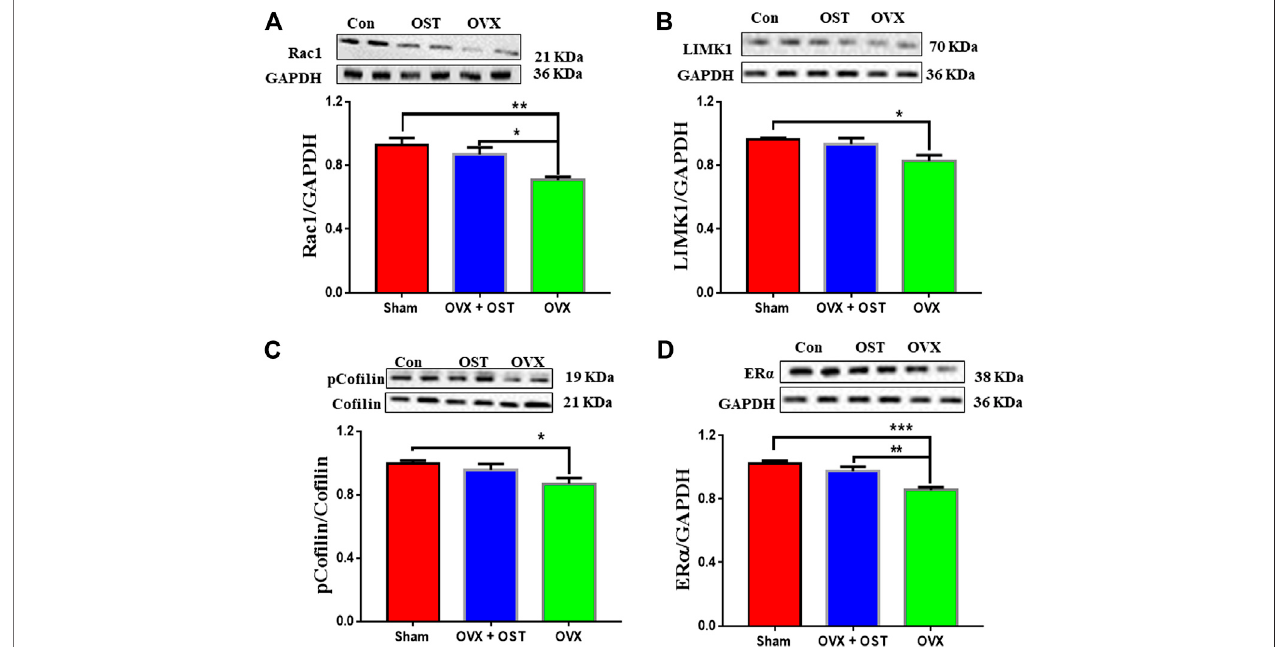
FIGURE 6 | Effects of OST on OVX-mediated alterations in the protein levels of Rac1, LIMK1, pCo fi lin/Co fi lin and ER α in the mouse hippocampus. The levels of Rac1 (A) ,LIMK1 (B) ,pCo fi lin/Co fi lin (C) andER α (D) wereassessedbyWesternblotanalysis.OVXcausedadecreaseinthelevelsoftheseproteins.TreatmentwithOST reversedthedecrease inthelevelsofRac1andER α ,butnotLIMK1andpCo fi lininthehippocampus. Dataarerepresented asmean ± SEM( n (cid:1) 5).* p < 0.05;** p < 0.01; *** p < 0.001.